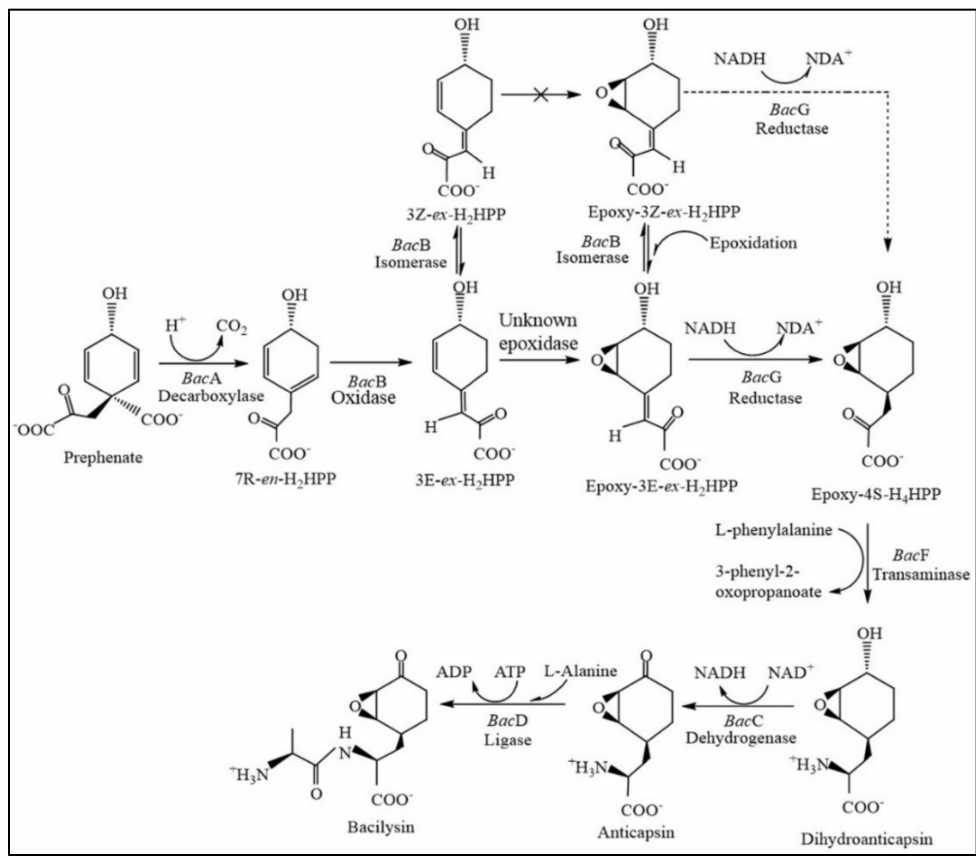
Figure 2. Bacilysin biosynthesis pathway according to Parker and Walsh